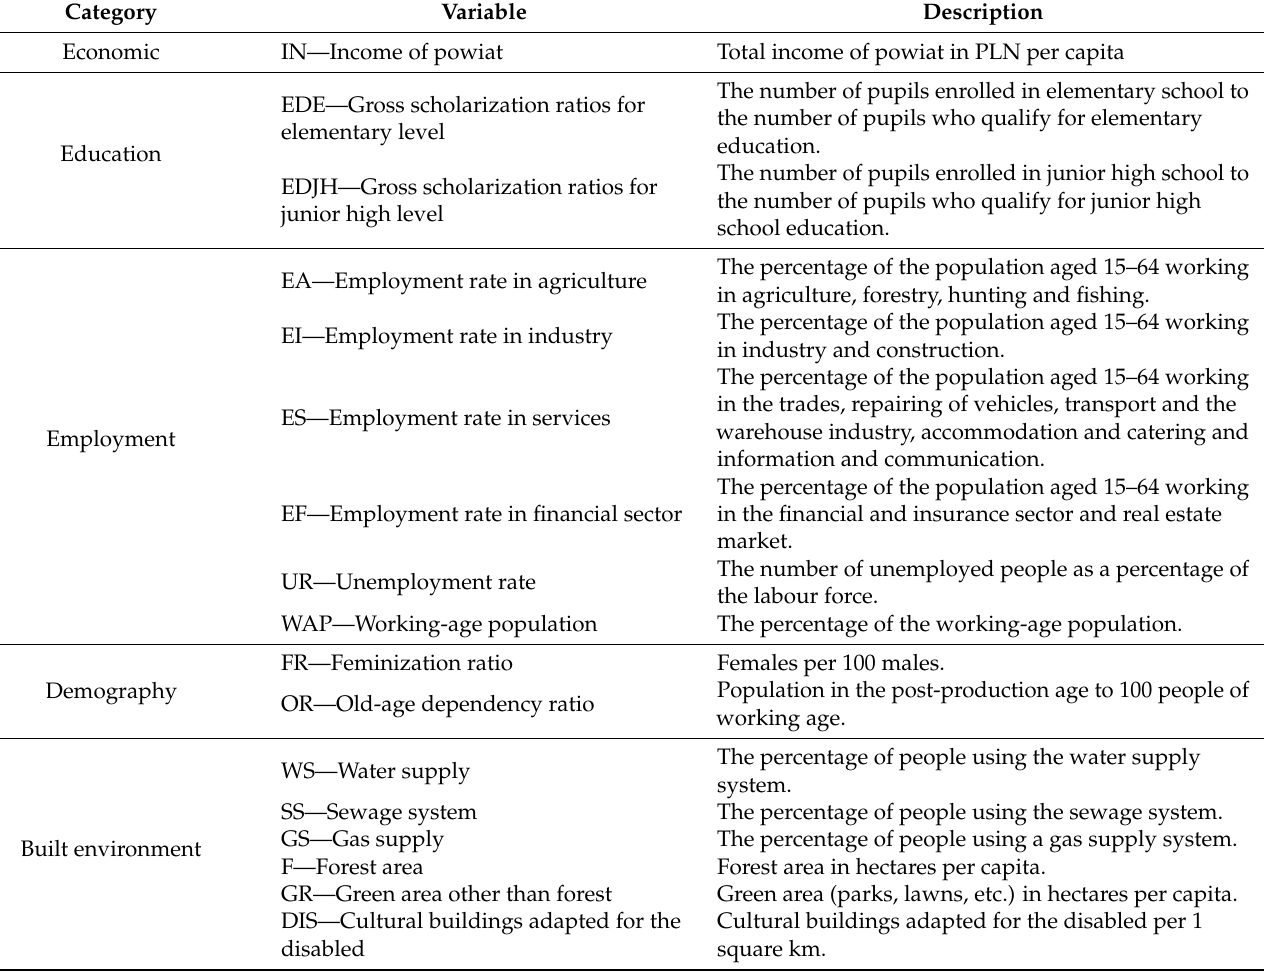
Table 3. Socioeconomic determinants of